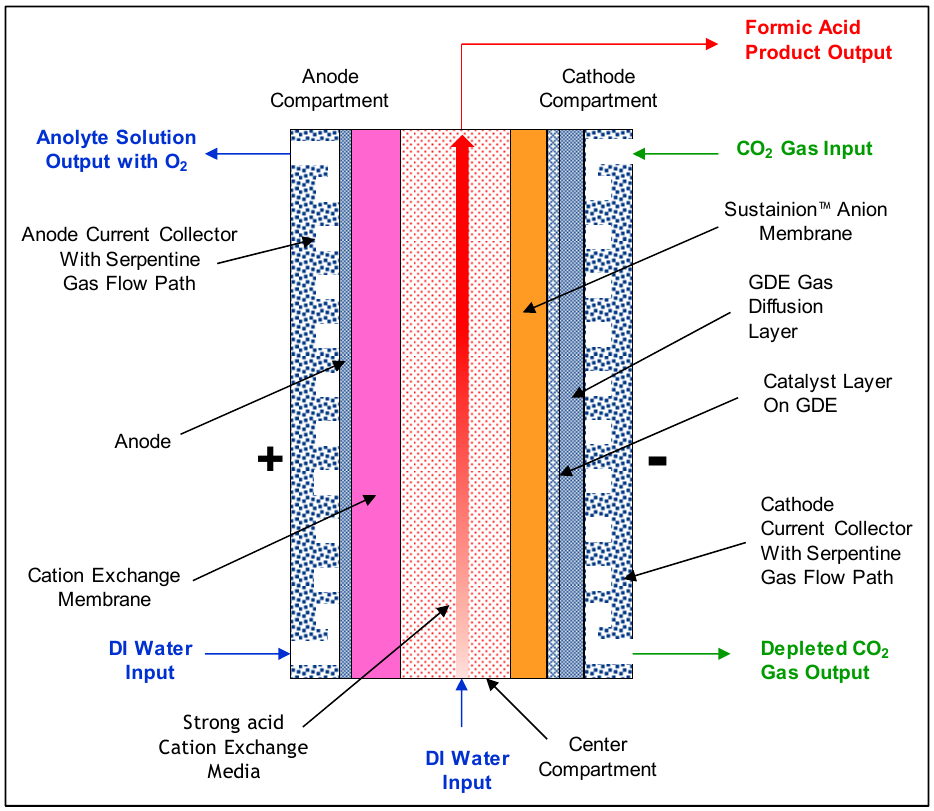
Figure 5. The design of a three-compartment electrolyzer cell that converts CO 2 and water into formic acid.